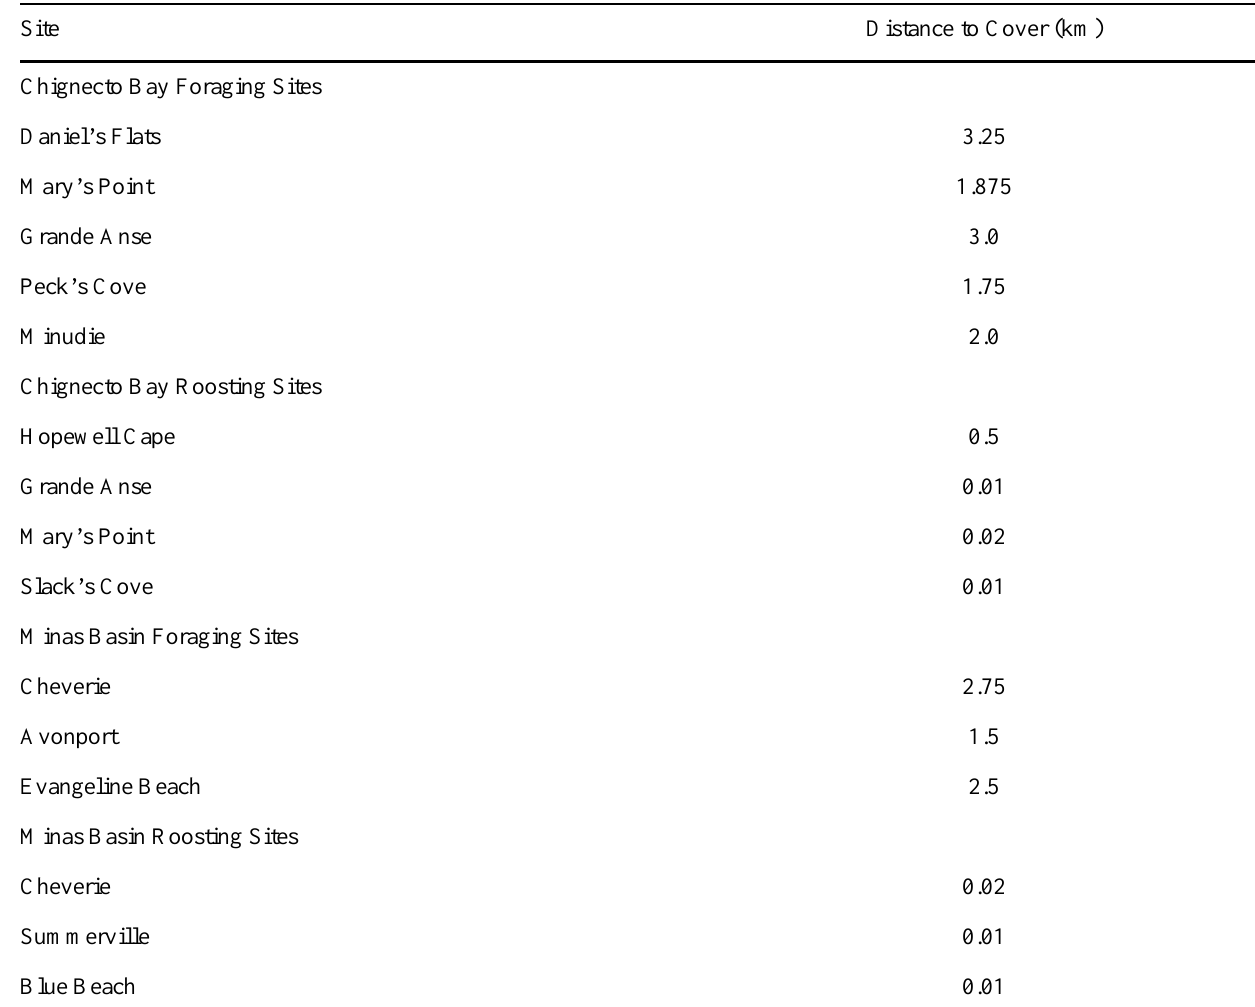
Table 3. Greatest distance (km) from cover that birds can forage or roost at each site in Chignecto Bay and Minas